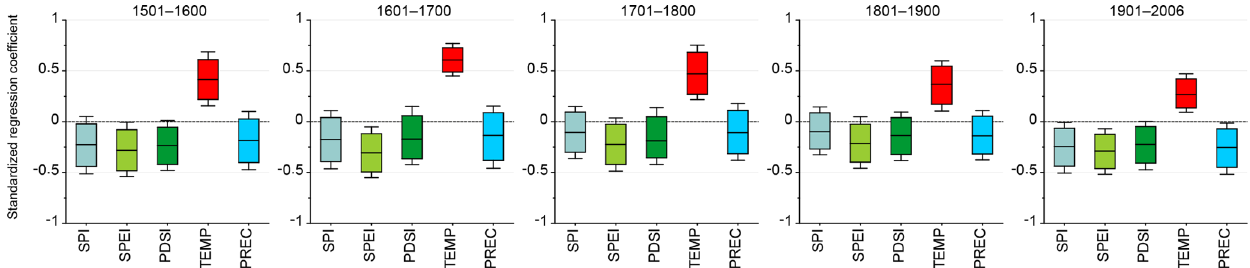
Figure 9. Standardized regression coefficients (central line, with 95% confidence interval shown as the box and 99% confidence interval as the whiskers), obtained for the NAO index (Luterbacher et al., 2001) in five nonoverlapping subintervals of the 1501–2006 period. Multiple linear regression was employed in a seven-predictor setup identical to the one in Fig. 4 (only coefficients for the NAO index are